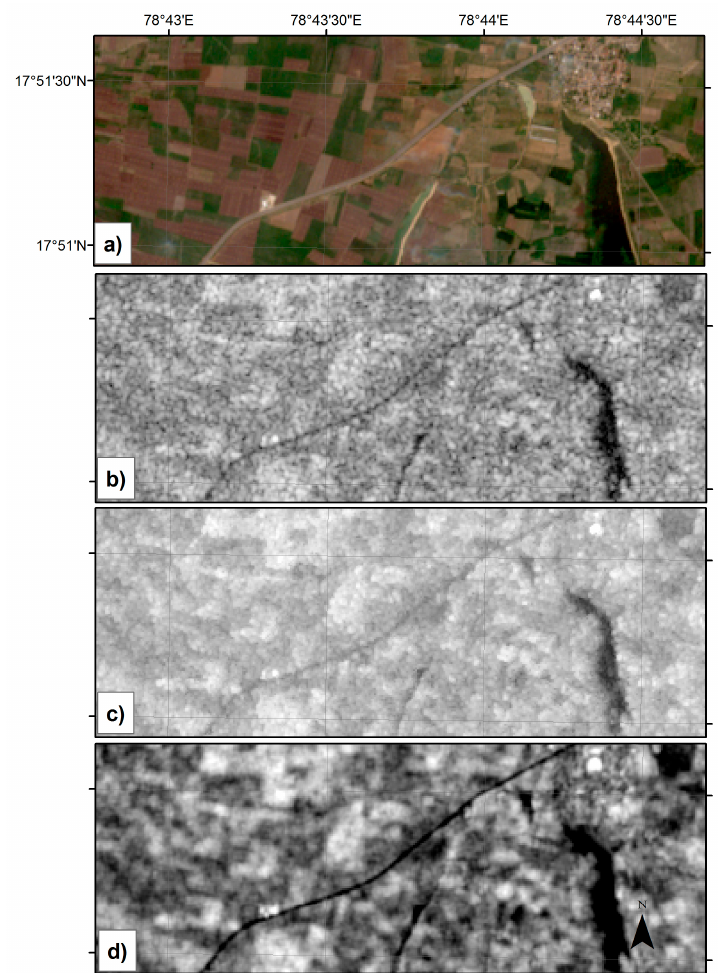
Figure 2. Multi-temporal speckle filter effect compared to spatial filter and raw Sentinel-1 data. ( a ) Enlargement of a part of the catchment as seen by Sentinel-2 visible bands (Red, Green, Blue color composite) on 26 October 2016. Green colors correspond to well-developed crops; brown areas correspond to bare soils. Roads, surface water and dams are visible at 10 m resolution; ( b ) raw Sentinel-1 L1C GRD VV band image from 30 October 2016, at 10 m resolution delivered by ESA; ( c ) Same Sentinel-1 VV band after use of spatial Lee filter [31]; ( d ) same Sentinel-1 VV band after use